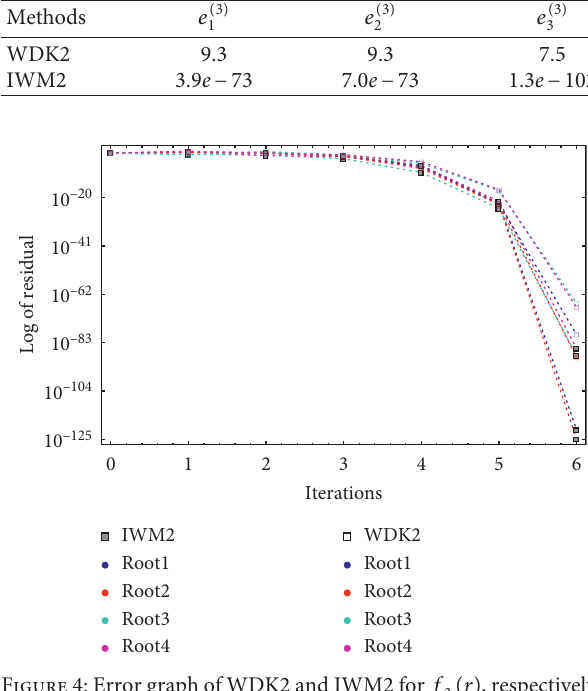
Figure 4: Error graph of WDK2 and IWM2 for f